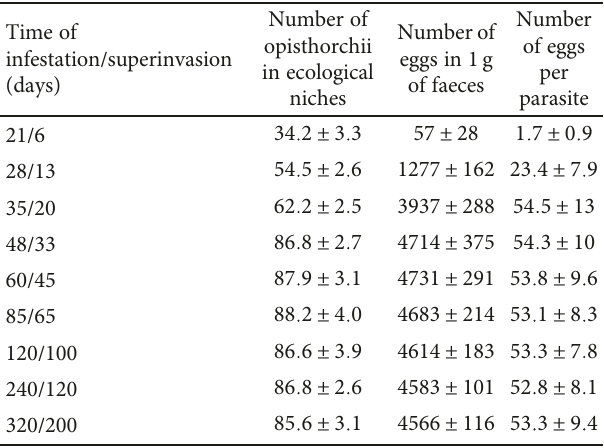
Table 1: Dynamics of the infestation intensity and egg production of O. felineus in experimental opisthorchiasis (SO).